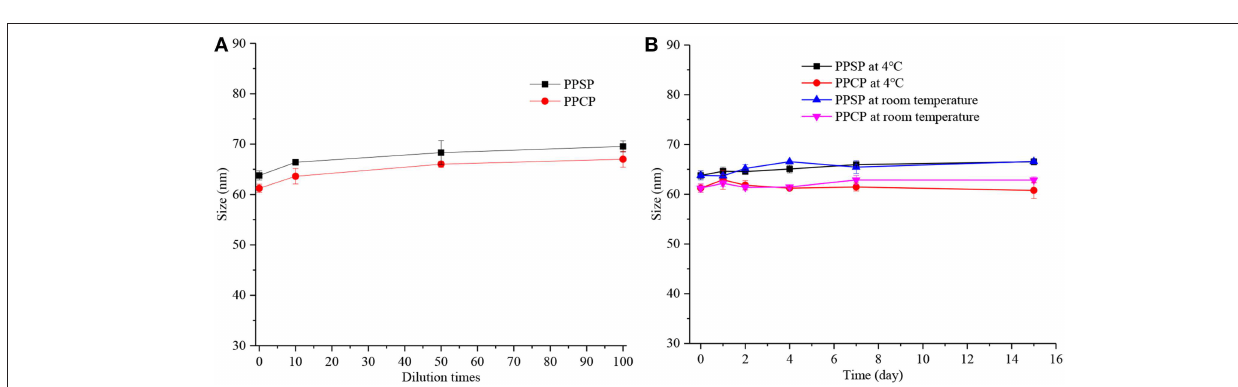
FIGURE 4 | The dilution stability (A) and storage stability (B) assay results.